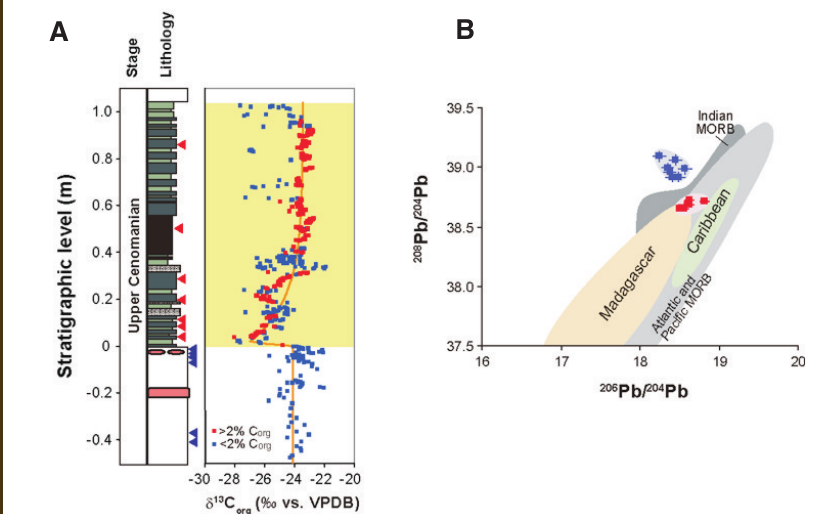
Figure 10. [A] A high-resolution profile of carbon isotopic composition of total organic matter from OAE-2 section from central Italy (Bonarelli Event, colored interval). Data from organic- rich (>2% total organic carbon content) and -poor (<2%) sediment are indicated by red and blue symbols, respectively. The profile indicates negative excursion at the base of the OAE-2. [B] A cross-plot of 206 Pb/ 204 Pb vs. 208 Pb/ 204 Pb in the Bonarelli (red symbols) and underlying Cenomanian limestone (blue symbols). For comparison, Pb isotopic compositions of basaltic rock from Caribbean (88–95 Ma), Madagascar flood basalts (88 Ma), and from MORB (present) from the Atlantic, Pacific, and Indian oceans are also shown. Both figures are referred from Kuroda et al.